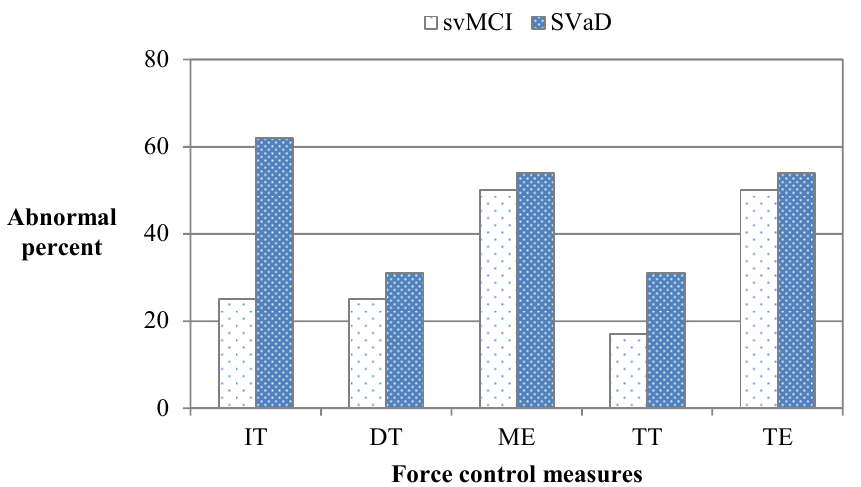
Figure 4. Percentages of patients outside the 99% confidence intervals of the force control capabilities of the normal group (IT: initiation time, DT: development time, ME: maintenance error, TT: termination time, TE: tracking error).